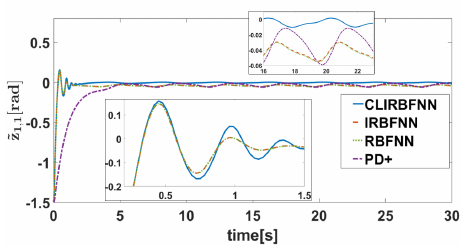
Figure 6. The tracking error of Joint 1.